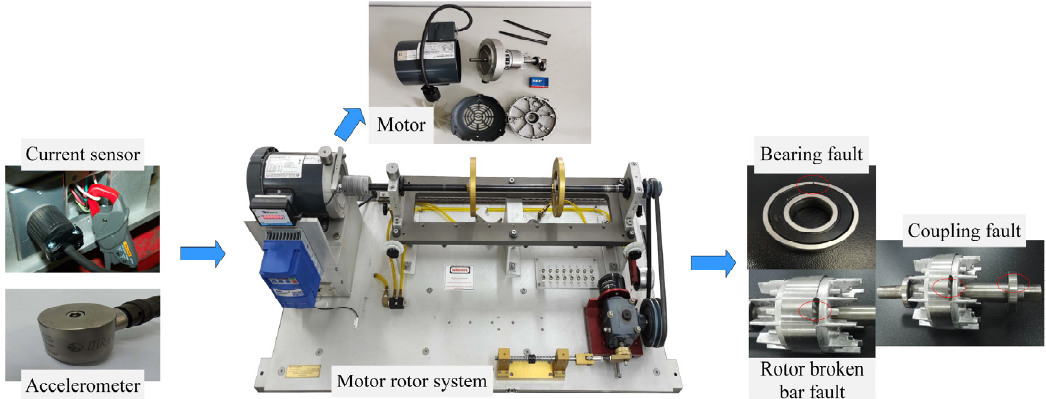
Figure 8. Structure of the experimental platform.